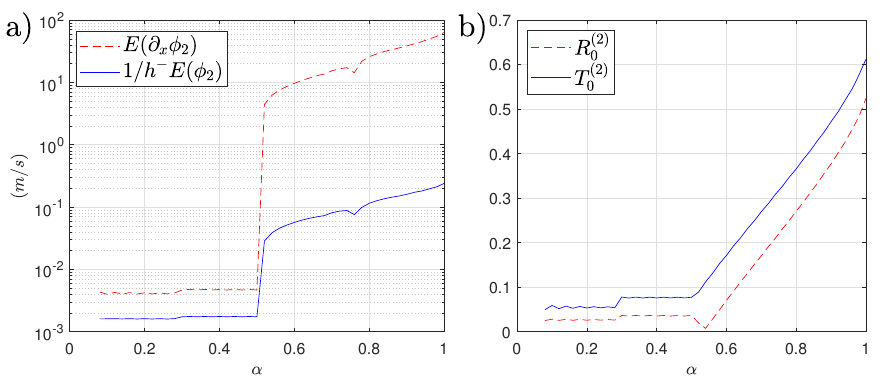
Figure 6. ( a ) Numerical error of the multimodal matching for the second-order functions φ 2 and ∂ x φ 2 as a function of the truncation parameter α . ( b ) Reflection and transmission coefficients of the free waves at the second order as a function of the truncation parameter α .